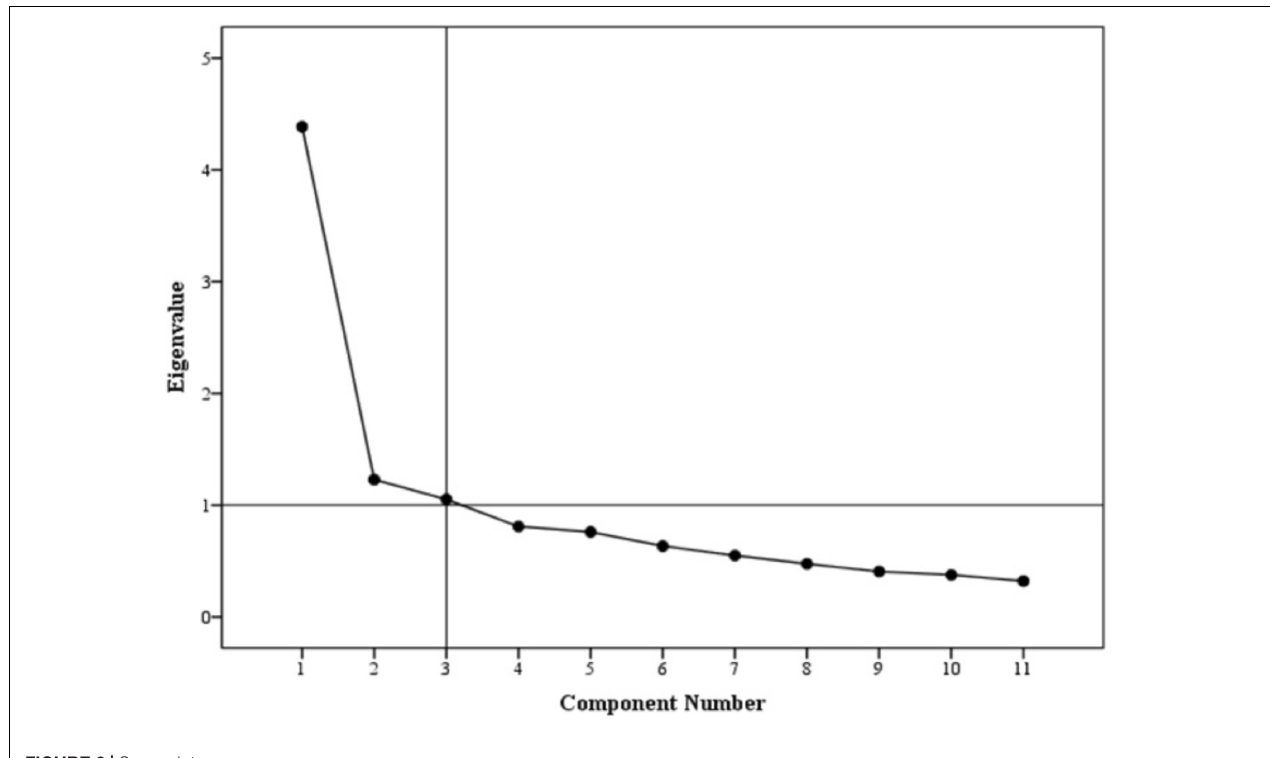
FIGURE 2 | Scree plot.